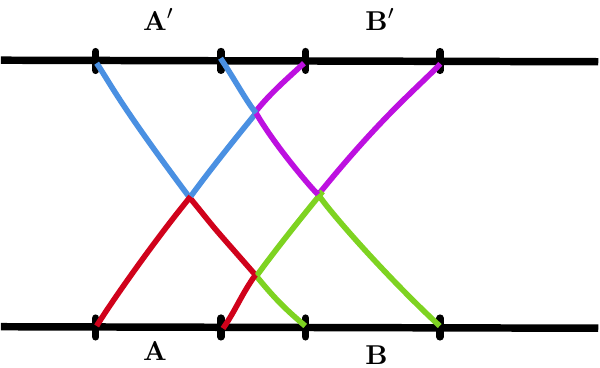
Figure 16 . A cutting-and-pasting proof that, if two pairs of straddling geodesics cross each other, then they cannot be minimal surfaces. The four geodesics can be rearranged into four non-minimal surfaces that end on A , A 0 , B and B 0 respectively. Hence their combined length must exceed S ( A ) + S ( B ) + S ( A 0 ) + S ( B 0 )